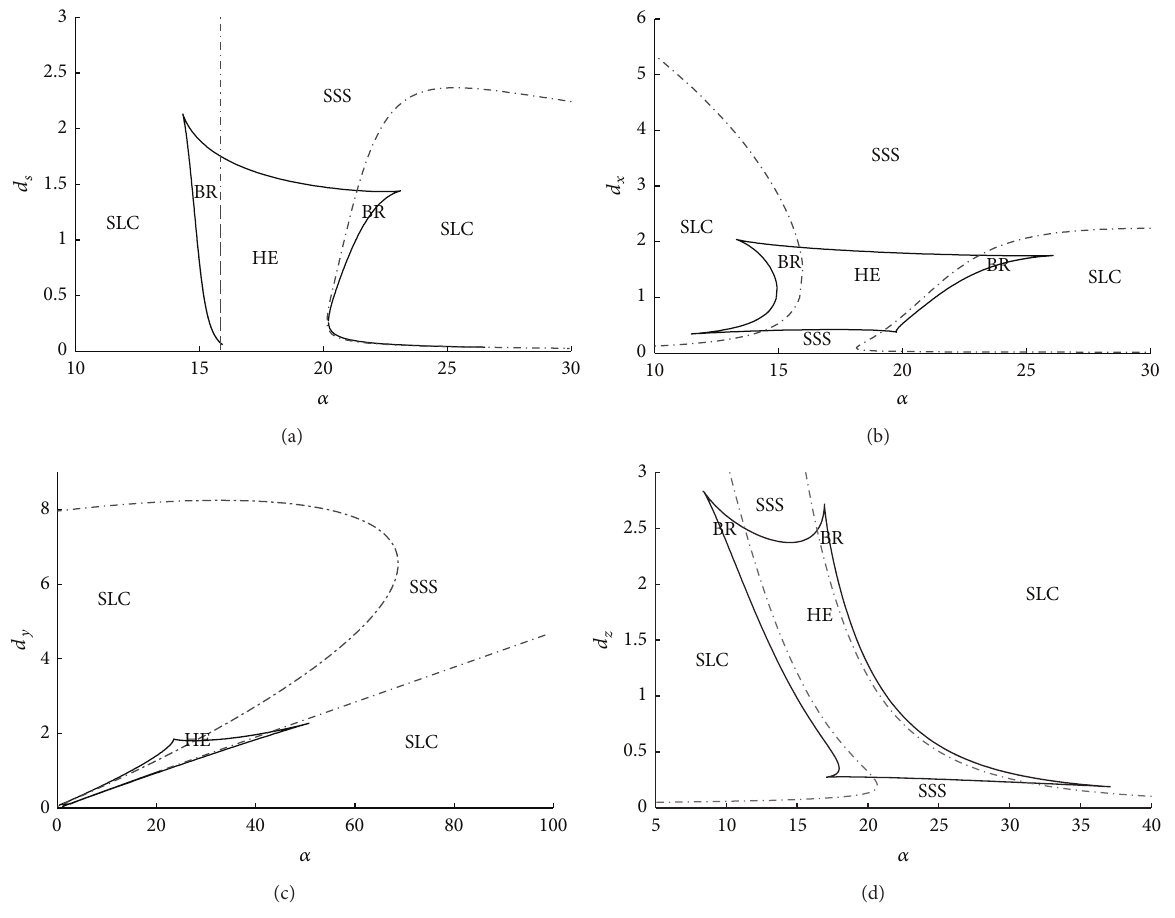
Figure 6: Bifurcation diagram of parameter 𝛼 versus parameters 𝑑 𝑠 , 𝑑 𝑥 , 𝑑 𝑦 , and 𝑑 𝑧 for model (1).